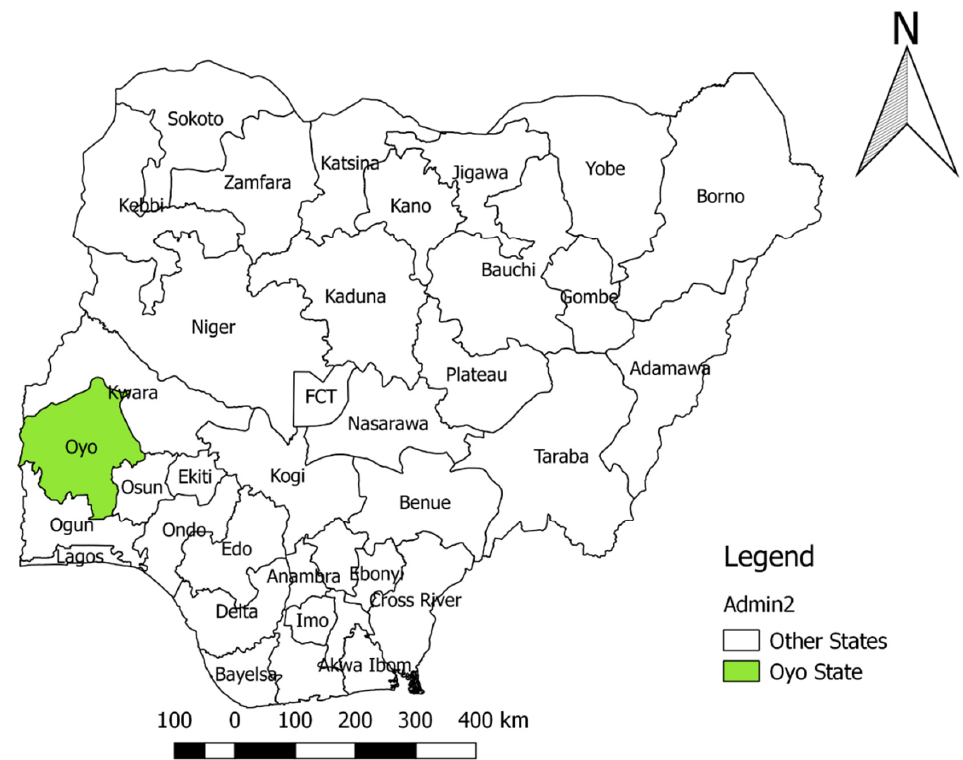
Figure 1. Map of Nigeria highlighting Oyo State in green.